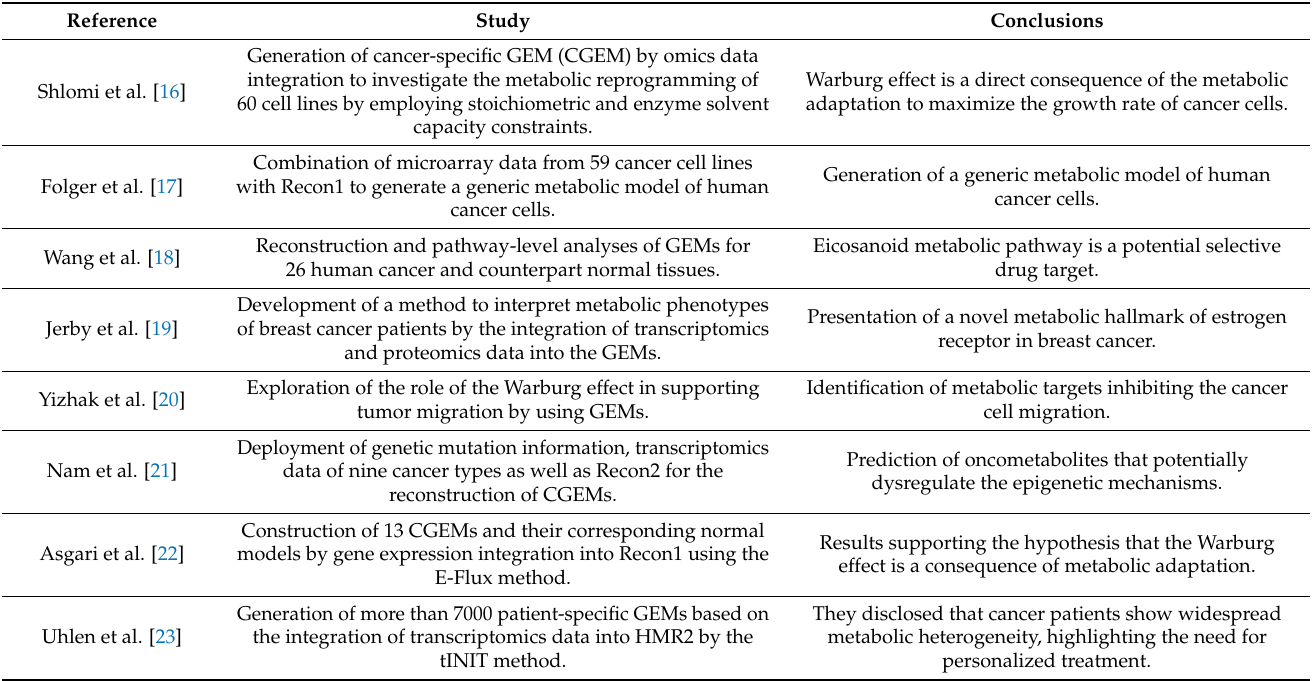
Table 1. Summary of studies that used omics databases and integration algorithms to generate CGEM. Reference Study Conclusions Shlomi et al.